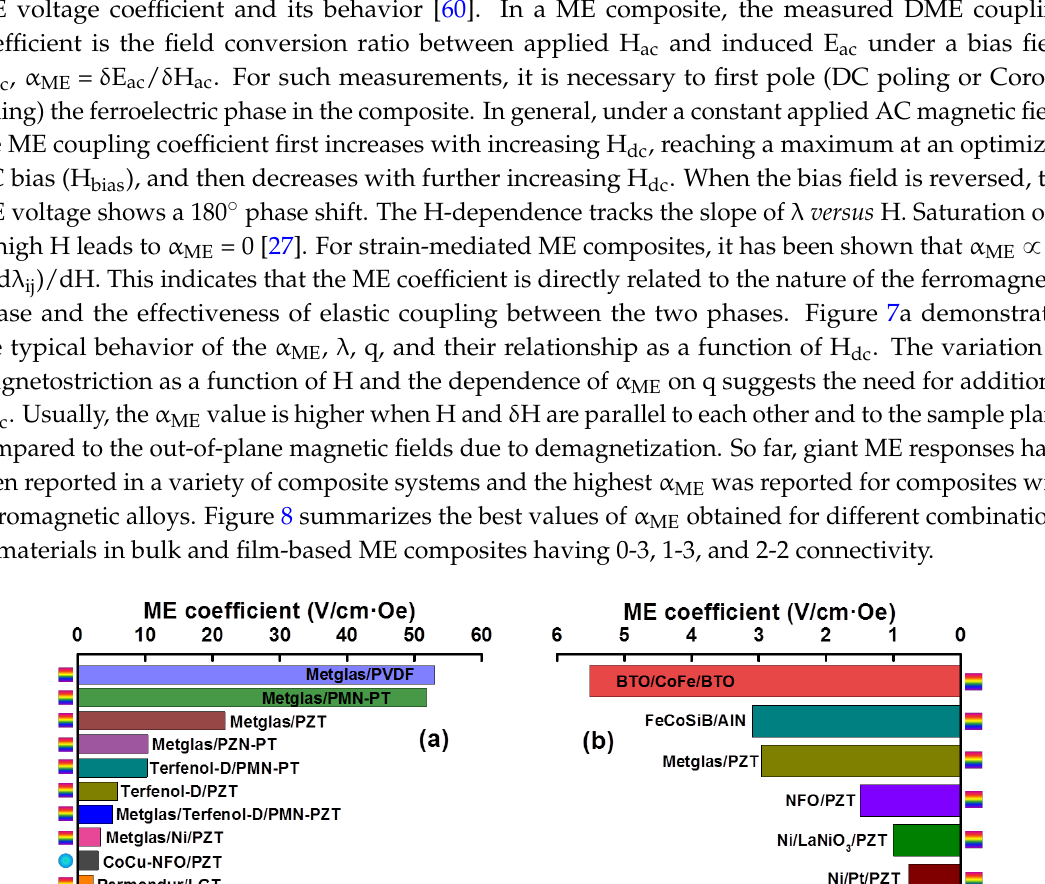
Figure 7. ( a ) Typical behaviors of magnetostriction, piezomagnetic coefficient, and ME coefficient as a function of DC magnetic field [60]. ( b ) Typical behaviors of impedance, capacitance, and DME and CME coefficients as a function of AC frequency [7].